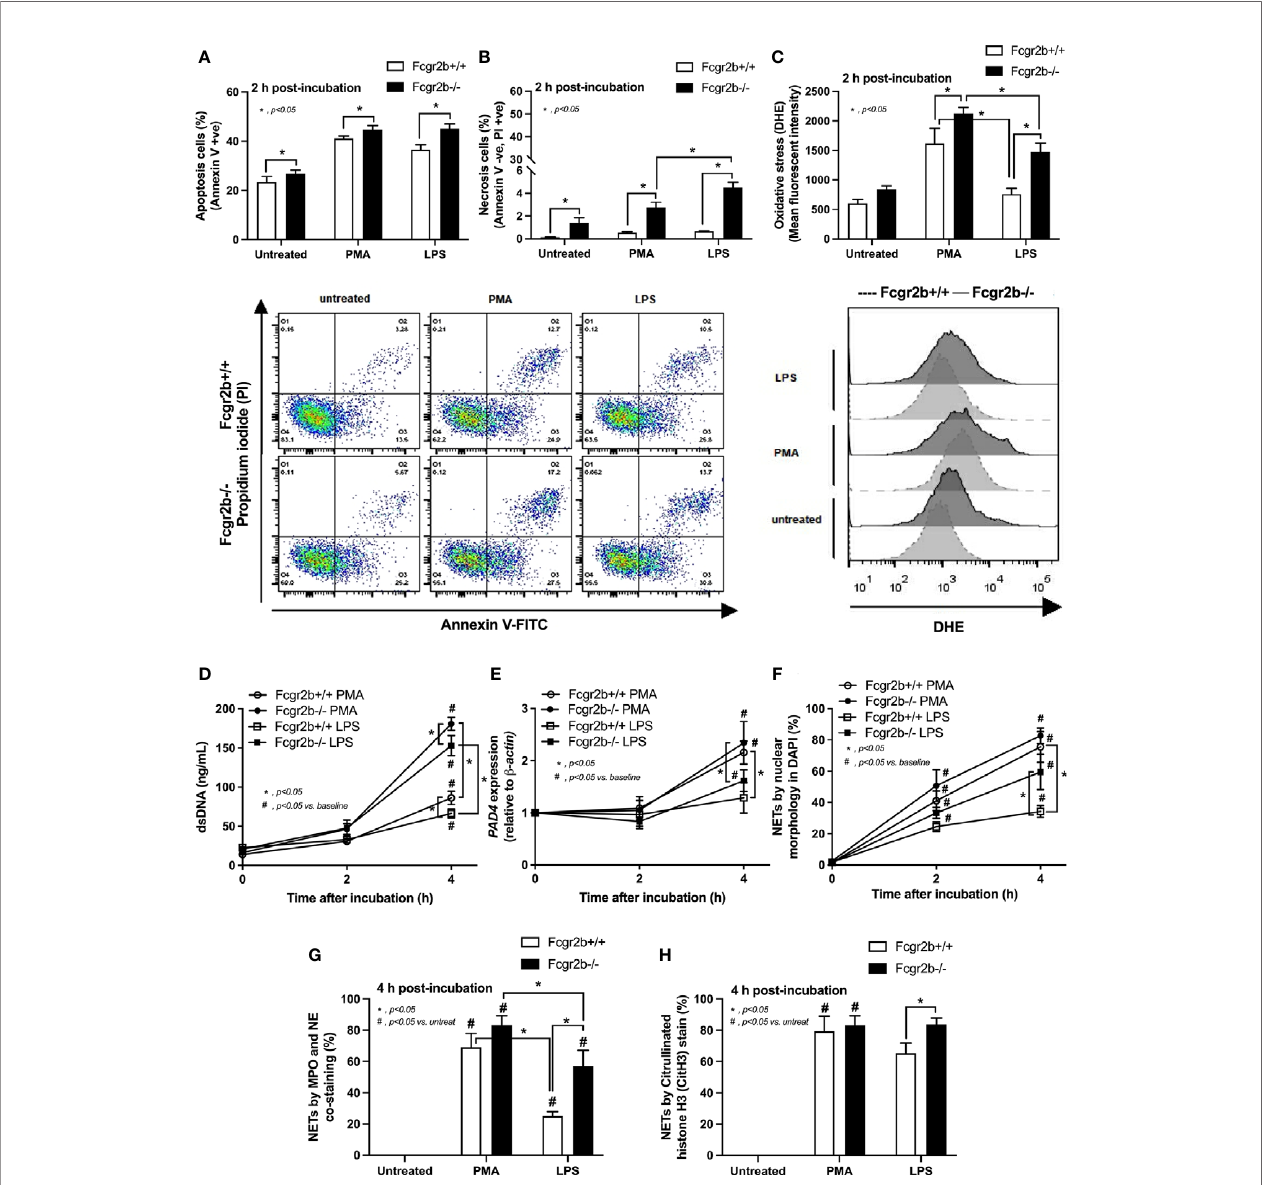
FIGURE 6 | Prominent apoptosis (with oxidative stress) and neutrophil extracellular traps (NETs) at 2 h and 4 h of the stimulation in neutrophils of lupus prone mice. Responses of Fcgr2b-/- and wild-type (Fcgr2b+/+) neutrophils after 2 h activation by phorbol myristate acetate (PMA), which is a NETs activator, or lipopolysaccharide (LPS), which is a TLR-4 stimulator, as evaluated using i) cell apoptosis, positive (+ve) Annexin V with negative (-ve) Propidium iodide (PI) or necrosis, -ve Annexin V negative with +ve PI, with the representative fl ow cytometry patterns (A, B) and ii) reactive oxygen species (ROS) using dihydroethidium (DHE) with the representative fl ow cytometry patterns (C) are demonstrated. Additionally, NETs were determined in time-points by supernatant dsDNA (D) , PAD4 expression (E) , nuclear morphology by 4 ’ ,6-diamidino-2-phenylindole (DAPI), a blue nuclear staining (F) and the co-staining of myeloperoxidases (MPO), and neutrophil elastase (NE) (G) or citrullinated histone H3 (CitH3) (H) at the 4 h of stimulation using immuno fl uorescence are demonstrated (independent triplicated experiments were NETosis (serum dsDNA, MPO, and glomerular NETs) and glomerular apoptosis ( Figures 10A – E ) in Fcgr2b-/- mice at 24 h post renal-I/R affected to decreased glomerular Ig deposition and attenuated lupus activity (anti-dsDNA, proteinuria and Scr) after 120 h post renal-I/R ( Figures 10F – I ). These data indicated that the attenuation of program cell death (apoptosis and NETosis) in renal injury by the Syk inhibitor could prevent lupus disease exacerbation.